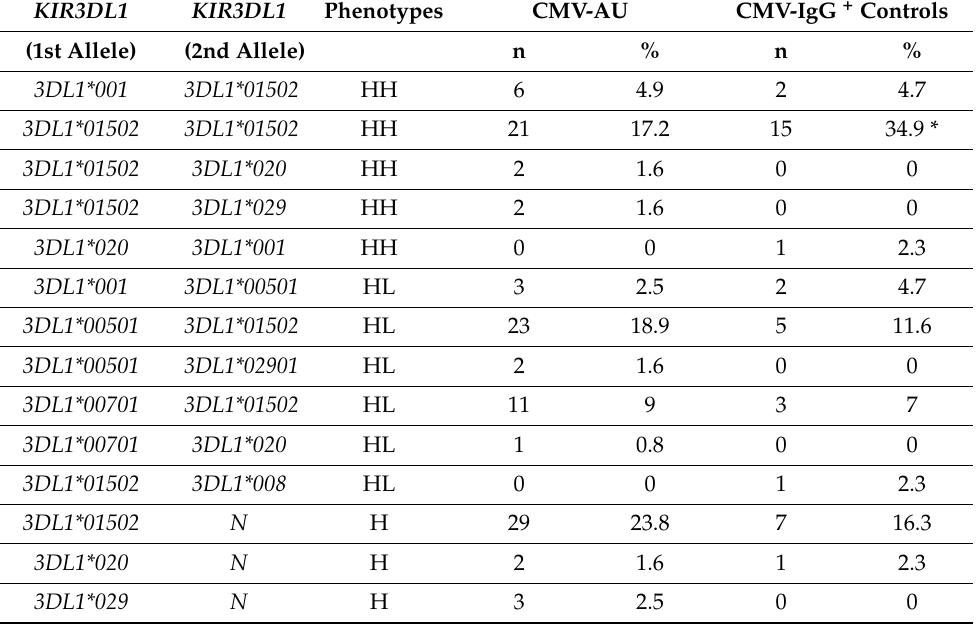
Table 3. KIR3DL1 allele-level genotypes in CMV-AU patients and CMV-seropositive healthy